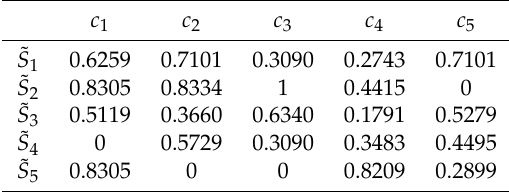
Table 3. Closeness coe ffi cients of